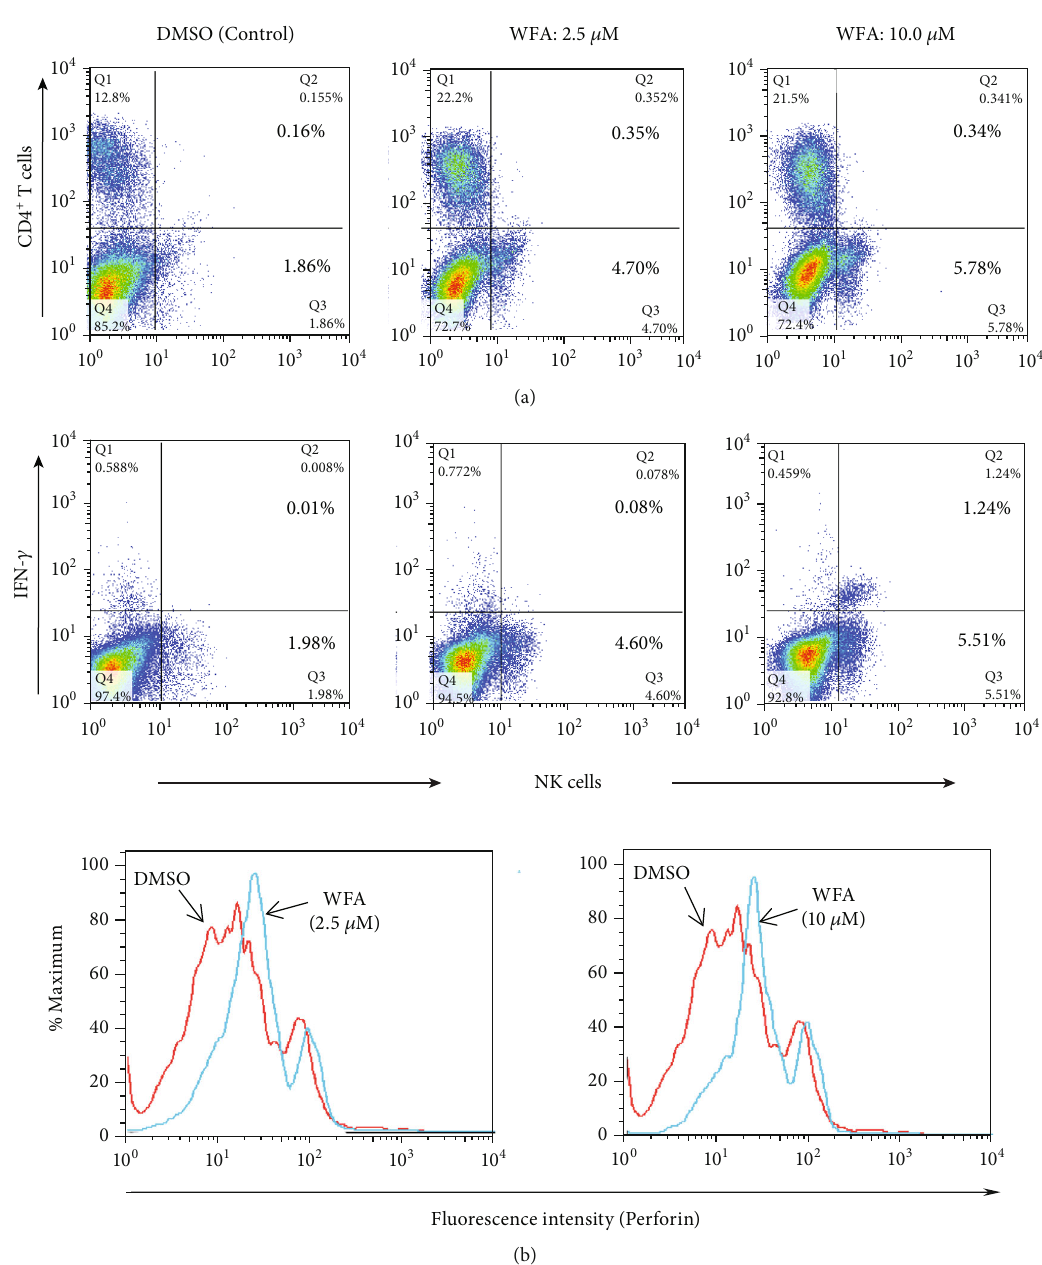
Figure 1: (a) WFA-induced frequency and (b) function (increase in IFN- γ and perforin) of NK cells examined by fl ow cytometry gated on CD8- negative T cells. Splenocytes from the naïve C57BL/6 mice were homogenized intoa single-cell suspension, seeded at a densityof 5 × 10 6 cells/well supplemented with cytokine IL-2 (10U/ml) in 24-well plates, and incubated overnight in the presence or absence of WFA and DMSO as